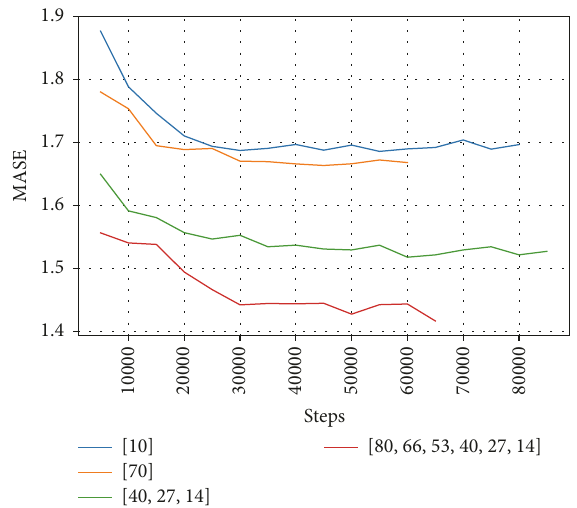
Figure 7: Trend in MASE for different FNNs with ReLU activation function and 6 h historical input data.